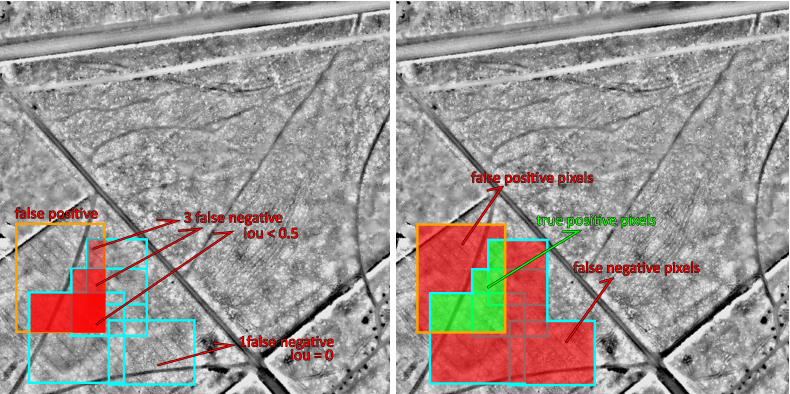
Figure 8. The IoU is not the ideal measure for landscape patterns since it does not take into account the amount of coverage between the predicted and the ground truth bounding boxes at a pixel level, but it considers if the whole predicted bounding box is a TP or an FP. ( Left ) All the intersections between the predicted ( (cid:110) ) bounding boxes and each ground truth’s ( (cid:110) ) bounding box are less than 0.5 times the corresponding union. The prediction is therefore considered as FP ( (cid:110) ) and all the ground truth’s bounding boxes are considered as FNs ( (cid:110) ). ( Right ) On the other hand, the pixel-based measure, in line with the archaeologists’ thinking process, considers the detection of landscape patterns as the classification of each pixel of an image: each pixel is therefore evaluated as TP, FP or TN without considering any threshold (see Figure 7 and Section